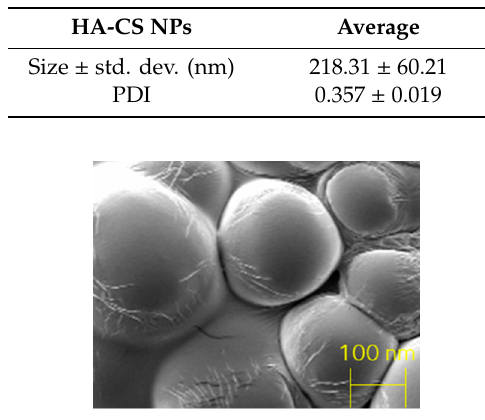
Figure 11. Hyaluronic acid (0.75 mg/mL)-chitosan (1% w / v ) nanoparticles, SEM.